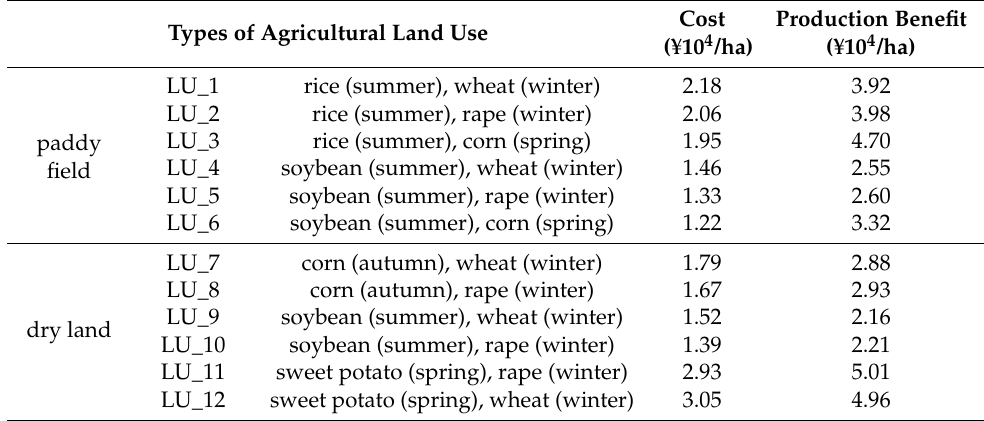
Table 2. Costs and benefits of different crop planting methods in different cultivated land